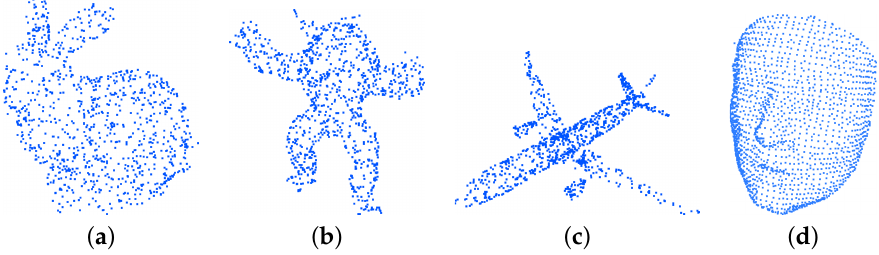
Figure 2. Test clouds: ( a ) Stanford Bunny; ( b ) Armadillo; ( c ) airplane; ( d ) human